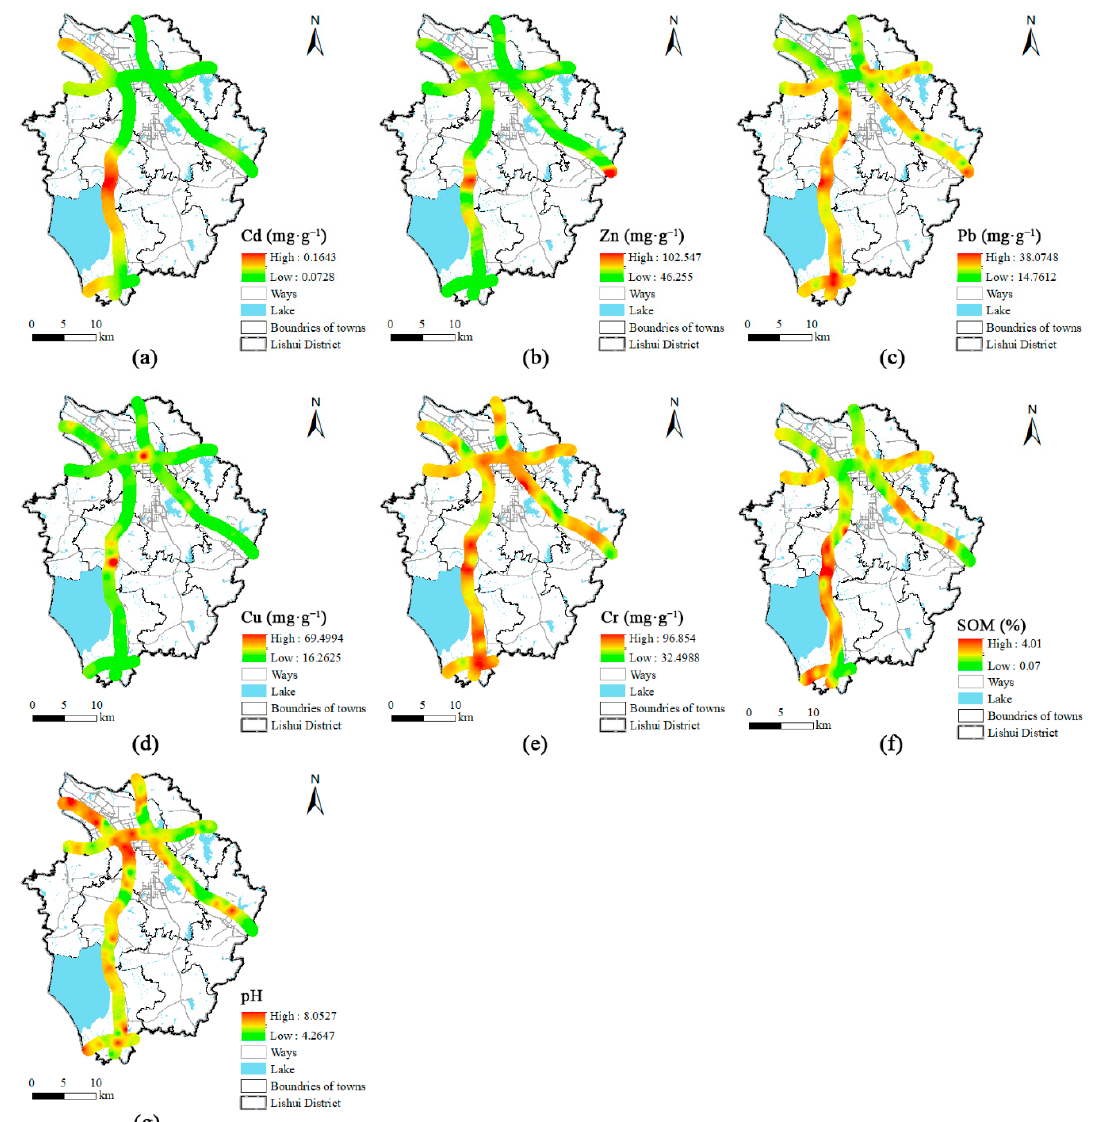
Figure 2. ( a ) Spatial distribution of the concentration of Cd; ( b ) spatial distribution of the concentration of Zn; ( c ) spatial distribution of the concentration of Pb; ( d ) spatial distribution of the concentration of Cu; ( e ) spatial distribution of the concentration of Cr; ( f ) spatial distribution of the concentration of SOM; ( g ) spatial distribution of the pH values. As shown by the results, the order of average single-factor pollution values was Cu > Cr > Cd > Pb > Zn. The average Pi values of Cu, Cr, Cd, Pb, and Zn were between 0.29